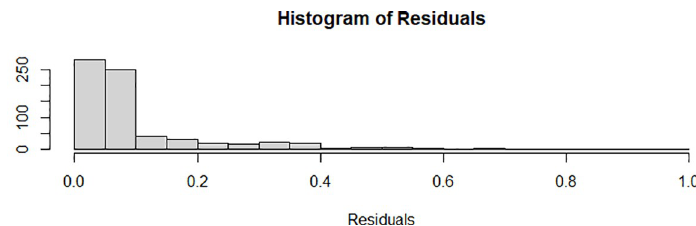
Fig 1. Histogram of the residuals of the latent class model with two classes. Source: own illustration.